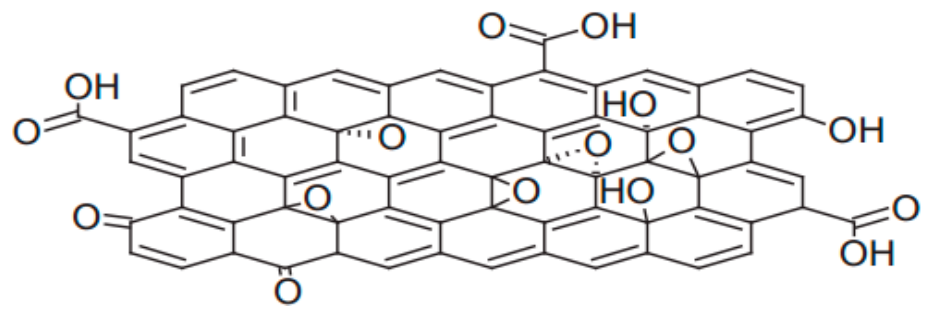
Figure 1. Structure mode of graphene oxide [23]. Copyright 2015 Journal of the Physical Society of Japan.